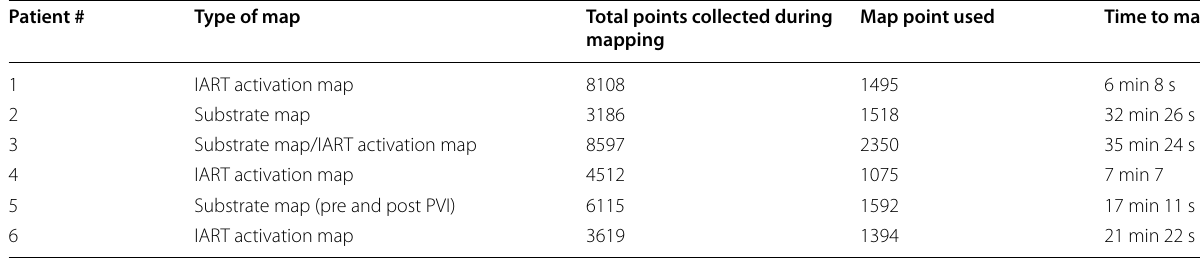
IART intra-atrial re-entrant tachycardia, PVI pulmonary vein isolation